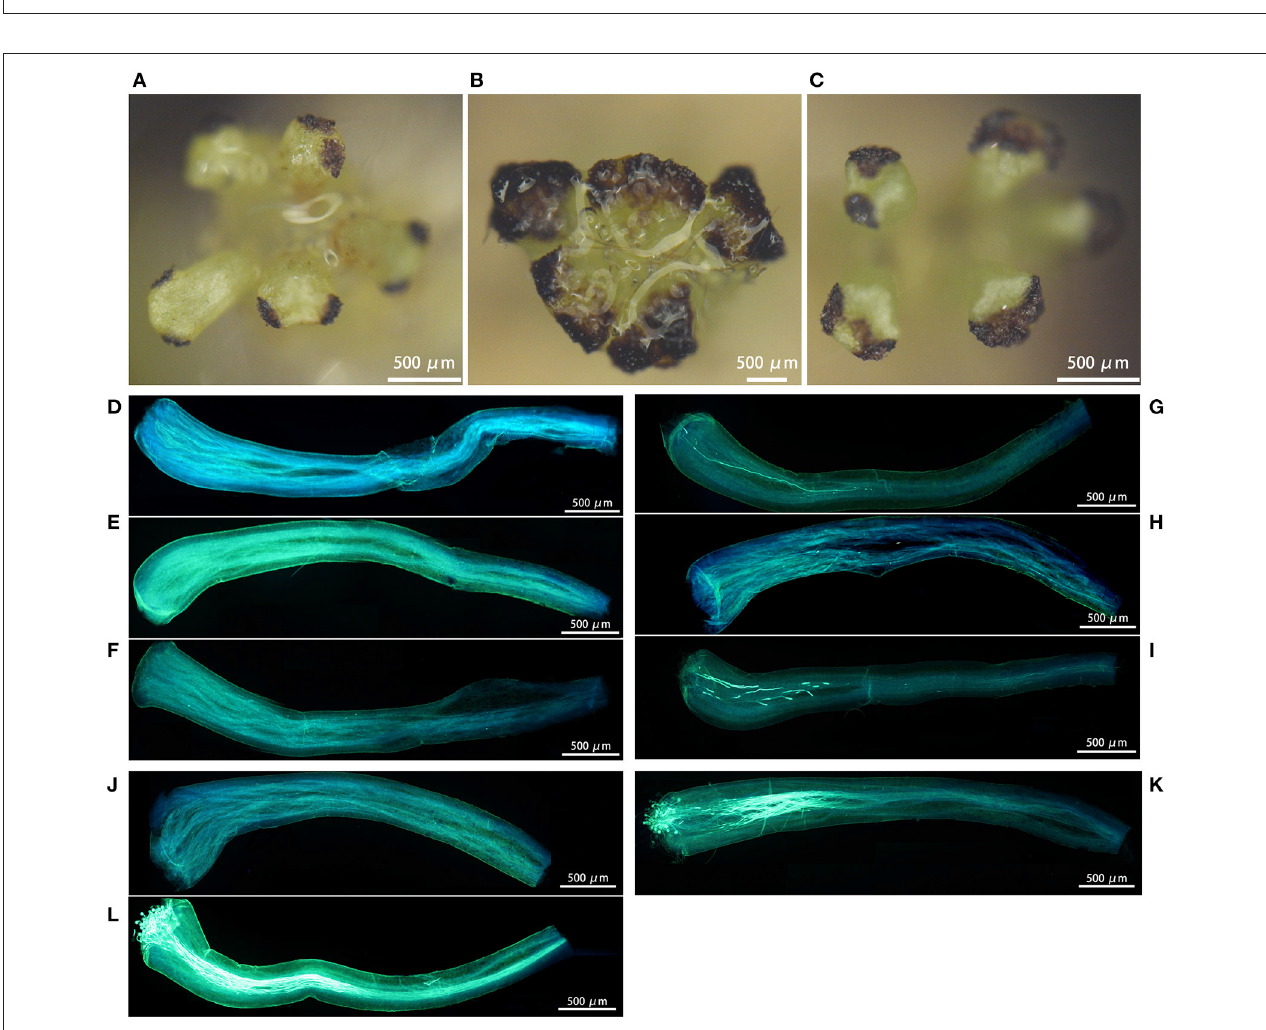
FIGURE 5 | and the bridge of chromosomes; (E1–E4) , prophase II, (E1) showing the dissociative chromosome, (E2) showing the micronucleus, (E3) showing the unequal separating of chromosomes, (E4) showing the doubled chromosomes; (F1–F4) , metaphase II, (F1) showing chromosomes lag and micronucleus, (F2) showing doubled chromosomes, (F3) showing perpendicular spindle, (F4) showing splayed spindle; (G1–G3) anaphase II, (G1) showing the splayed spindle chromosomes lag, (G2) showing perpendicular spindle and chromosomes lag, (G3) showing cross spindle and micronucleus; (H1–H4) , telophase II, (H1) showing chromosomes lag and micronucleus, (H2) showing unequal separation of chromosomes, (H3) showing triad and micronucleus, (H4) showing polyad. (I–P5) , images of PMCs meiosis of H411: (I) showing the univalent (arrowhead), trivalent (arrow), and quadrivalent (red arrow); (J1,J2) , metaphase I, (J1) showing chromosomes lag, (J2) showing doubled chromosomes. (K1,K2) , anaphase I, (K1) showing chromosome lag and chromosome bridge, (K2) showing chromosomes bridge; (L) showing chromosomes lag and micronucleus in telophase I; (M) showing micronucleus in prophase II; (N) showing chromosomes lag in metaphase II; (O1,O2) , anaphase II, (O1) showing chromosomes lag and chromosomes bridges, (O2) showing chromosome bridge; (P1–P5) telophase II, (P1) showing unequal separating of chromosomes, (P2) showing dyad, (P3) showing triad and micronucleus, (P4,P5) showing polyad and micronucleus. (Q–R2) , images of PMCs meiosis of B336: (Q)